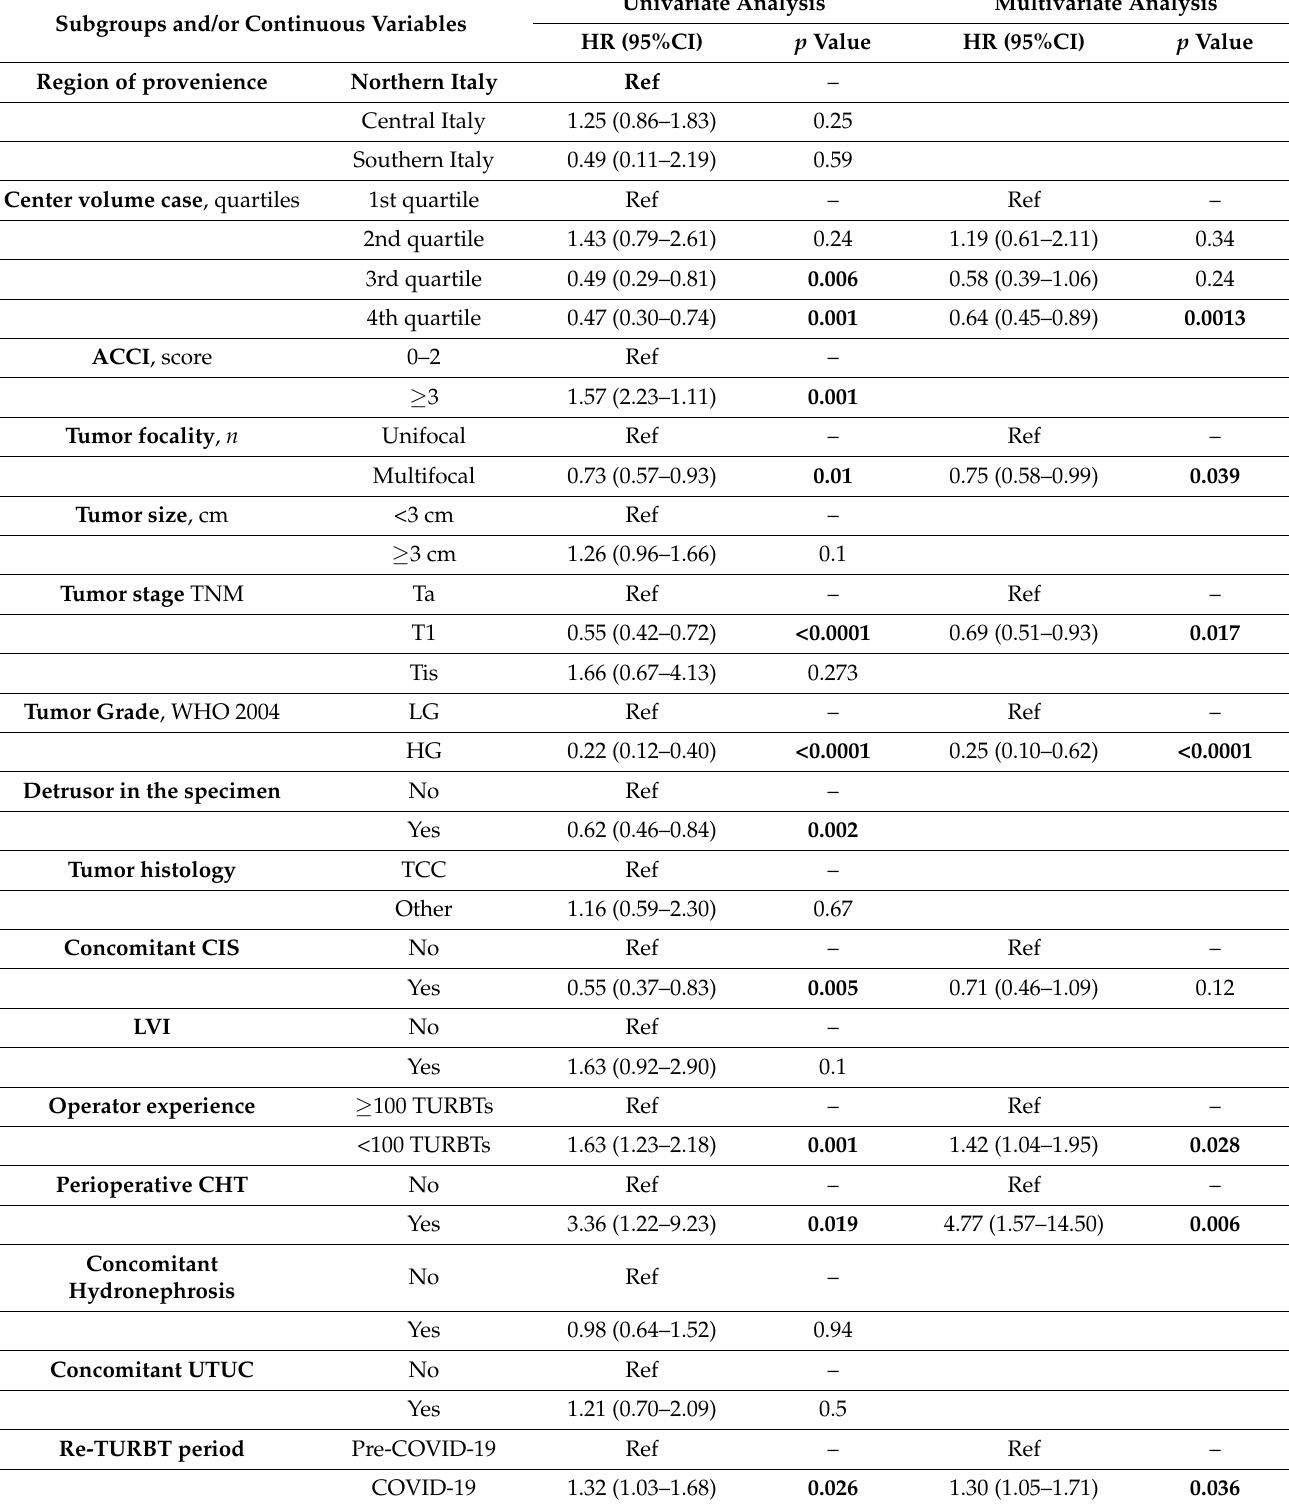
Table 5. Univariable and multivariable logistic regression analysis for delayed time to adjuvant intravesical therapy (induction). In bold, value <